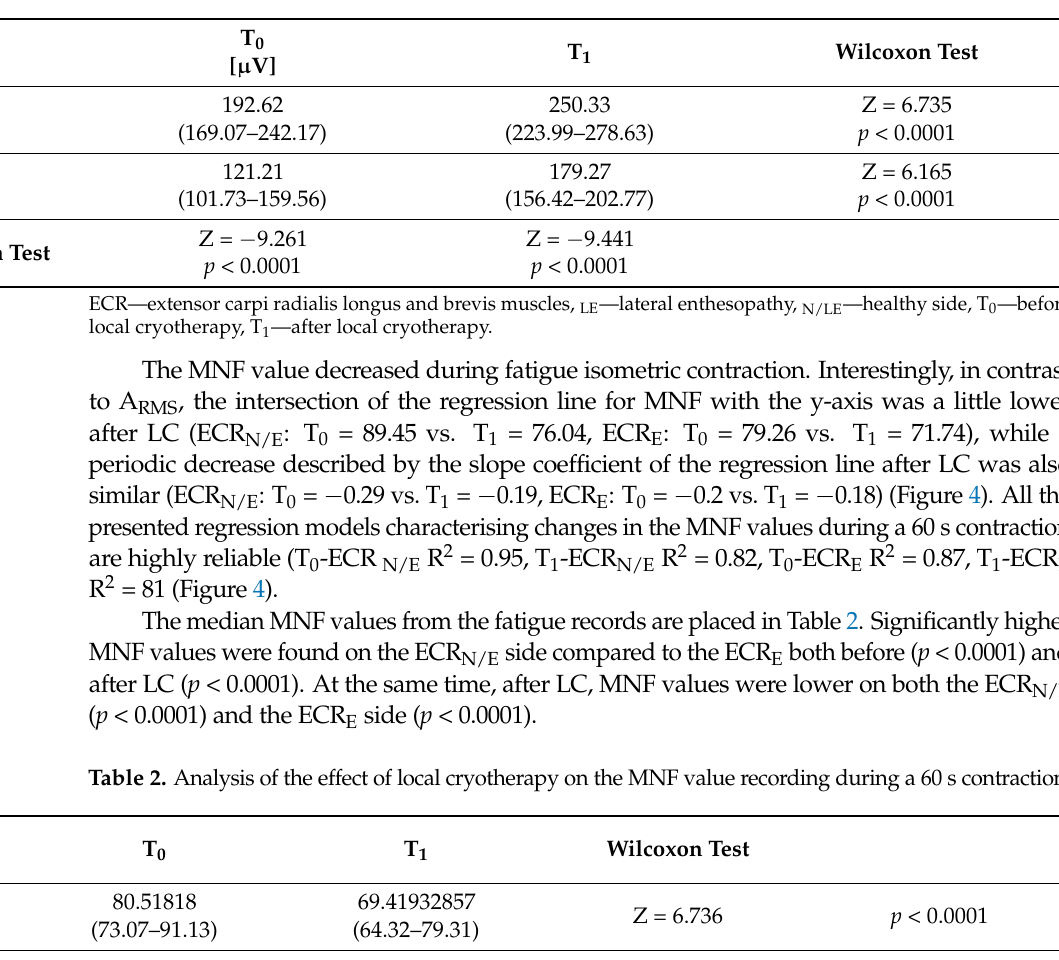
Table 1. Analysis of the effect of local cryotherapy on the A RMS value recording during a 60 s contraction.